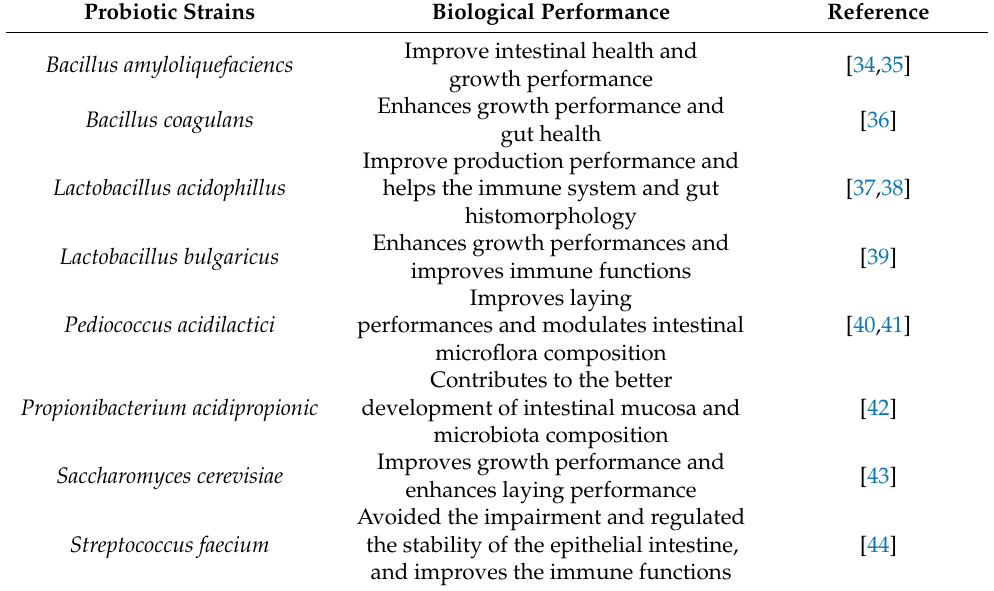
Table 1. Summary of the beneficial probiotics on poultry performance. Probiotic